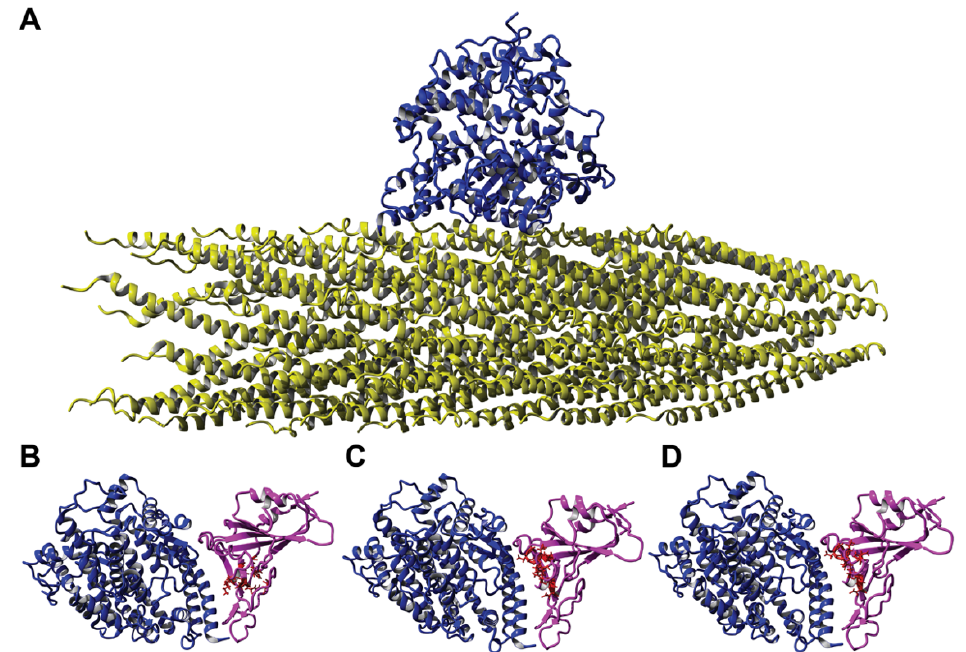
Figure 6. Interaction of ACE2 with different ligands. ( A ) Interaction of a landscape phage displaying the peptide DGRADLSYD on the full-length p8 protein (yellow) with ACE2 (blue) as determined using homology modeling. Here, a segment containing less than 1% of the landscape phage is presented, where the DGRADLSYD peptide is presented as an N-terminal fusion to all copies of the mature p8 major coat protein. Molecular model 6M0J demonstrating the interaction between ACE2 protein (blue) and recombinant SARS-CoV-2 spike RBD (pink) with amino acid clusters corresponding to phage mimotopes. ( B ) DGRADLSYD; ( C ) VGIDEQRAD; and ( D ) DGRSIVGDE, highlighted in red.